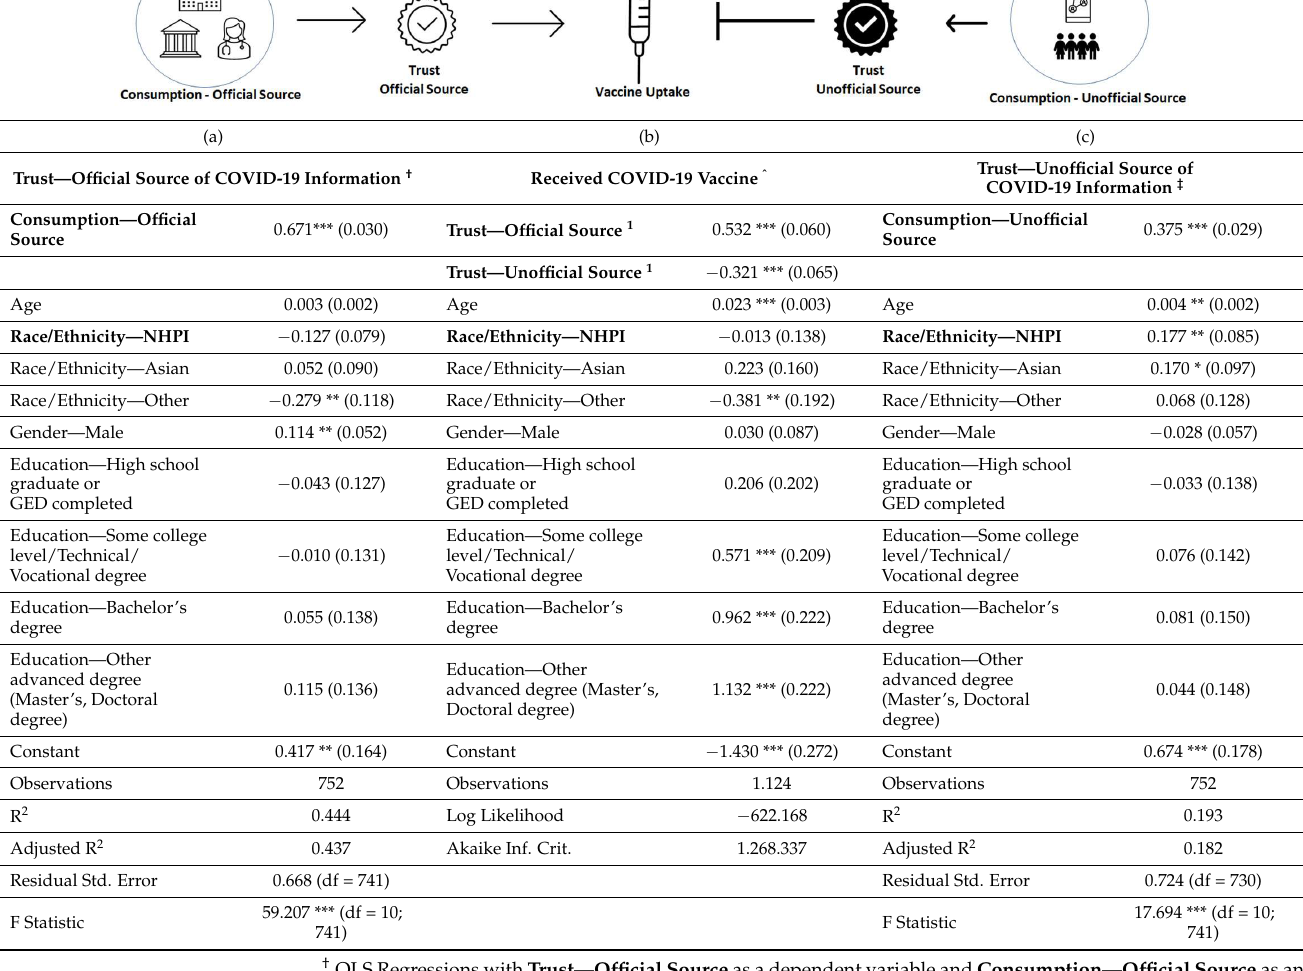
Table 3. The mechanism for vaccine uptake as a function of Trust and Consumption in Official and Unofficial sources. From left to right: (a) OLS Regression of Trust-Official Source as the dependent variable, Consumption-Official Source and demographics as independent variables; (b) Probit re- gression of Vaccination Status as the dependent variable, and Trust-Official Source, Trust Unofficial Source, and demographics as independent variables; (c) OLS regression of Trust-Unofficial Source as the dependent variable, Consumption-Unofficial Source and demographics as independent variables.